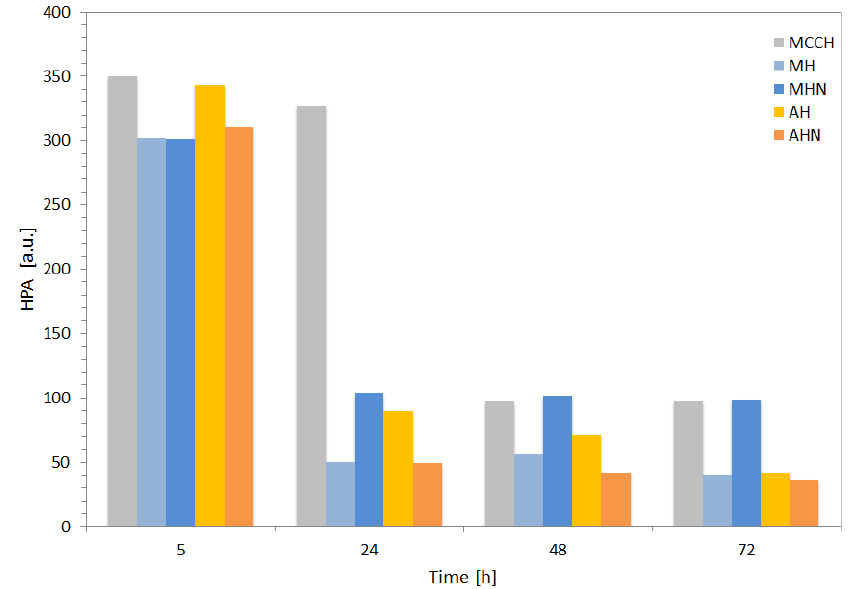
Fig. 5 Comparison of changes in hydroxyl peak area (HPA) during air-drying for MCC treated in water using MCC:silane mass ratio of 1:1 (MH, AH) and 1:6 (MHN, AHN),